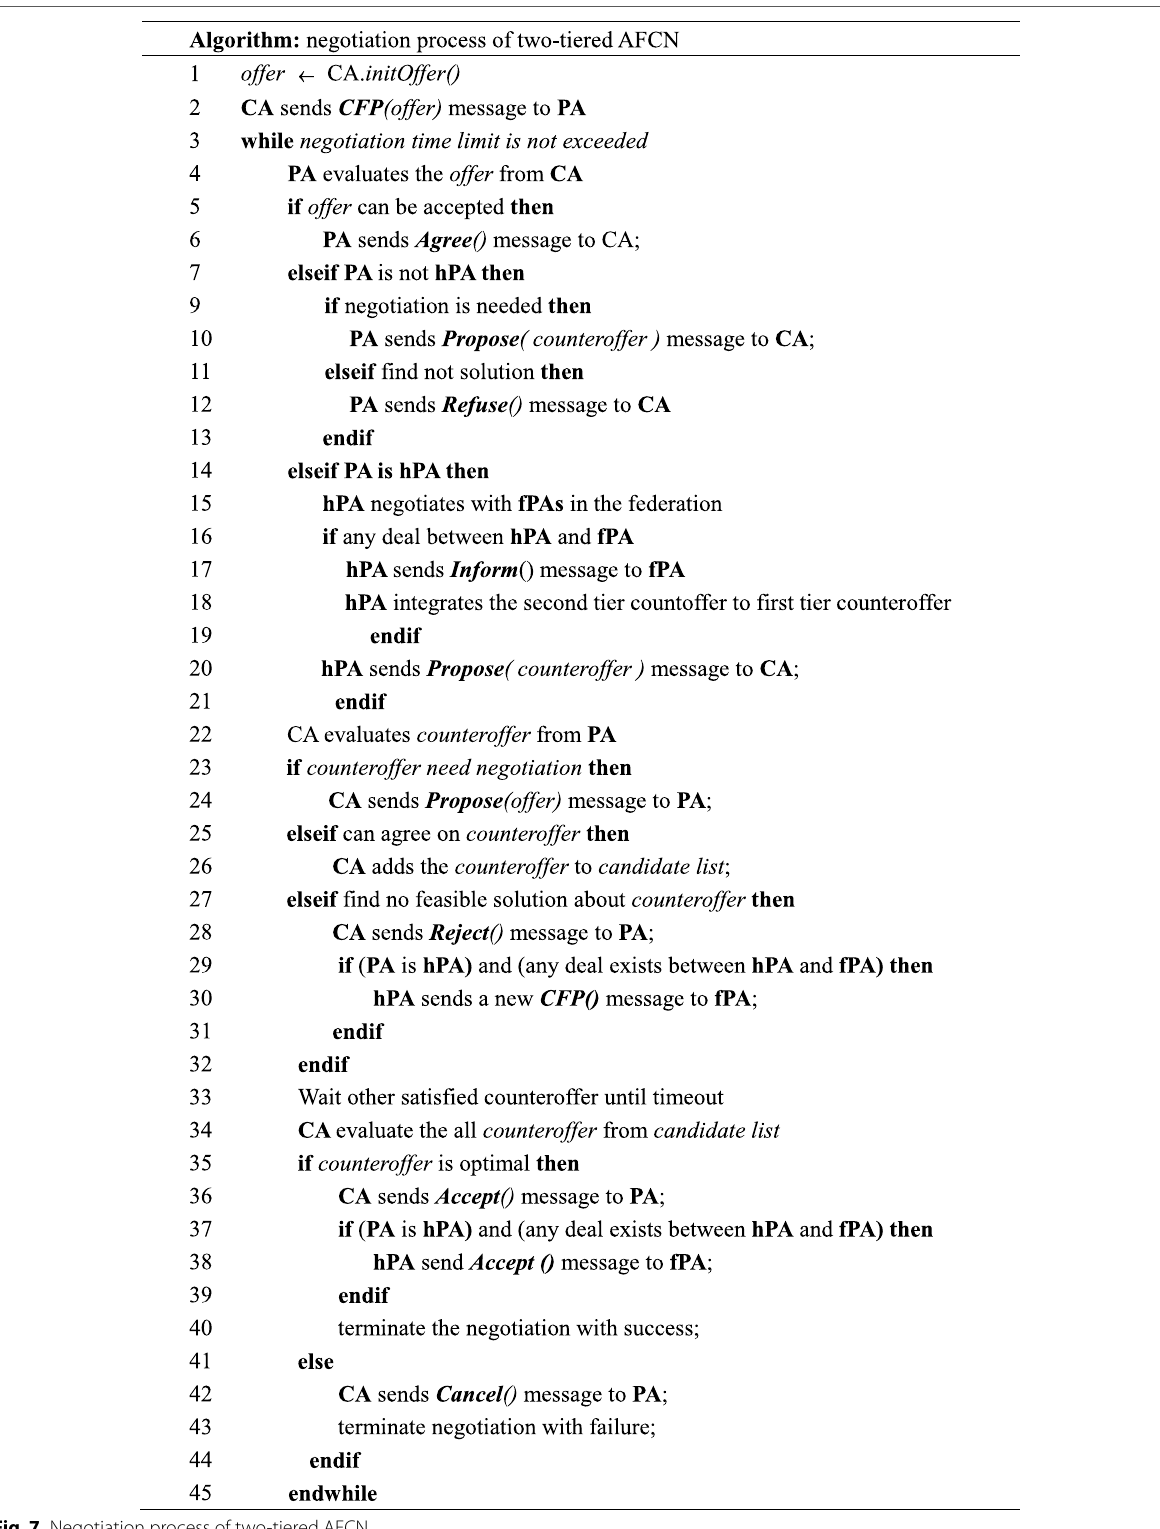
Fig. 7 Negotiation process of two-tiered